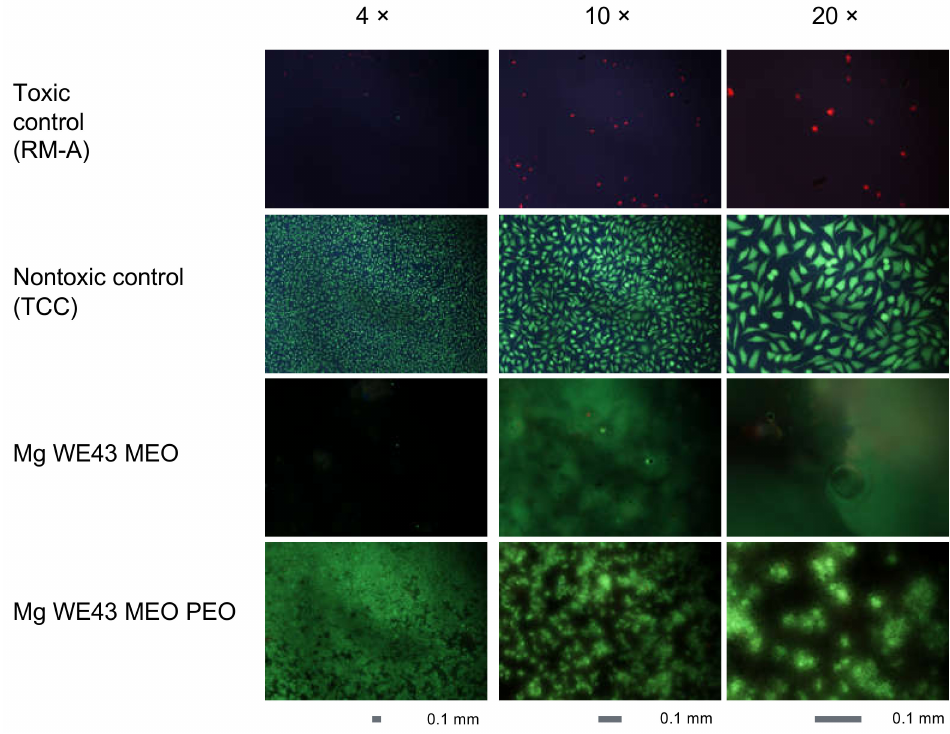
Figure 6. Live/dead staining assay results for L-929 cells that were directly seeded and cultured for 24 h on the material specimens. Nuclei of dead cells with compromised plasma membrane integrity are stained red by propidium iodide while the green dye fluorescein diacetate exclusively stains viable cells. The scale bars indicate a length of 0.1